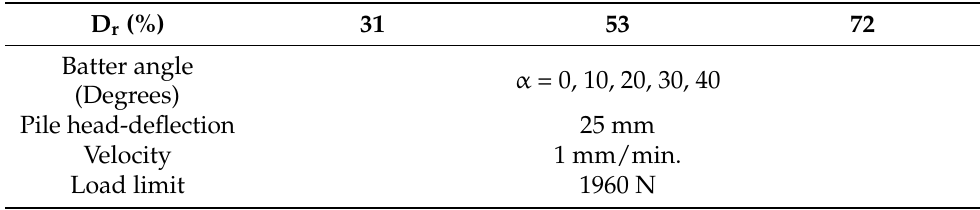
Table 5. The summary of test cases in model